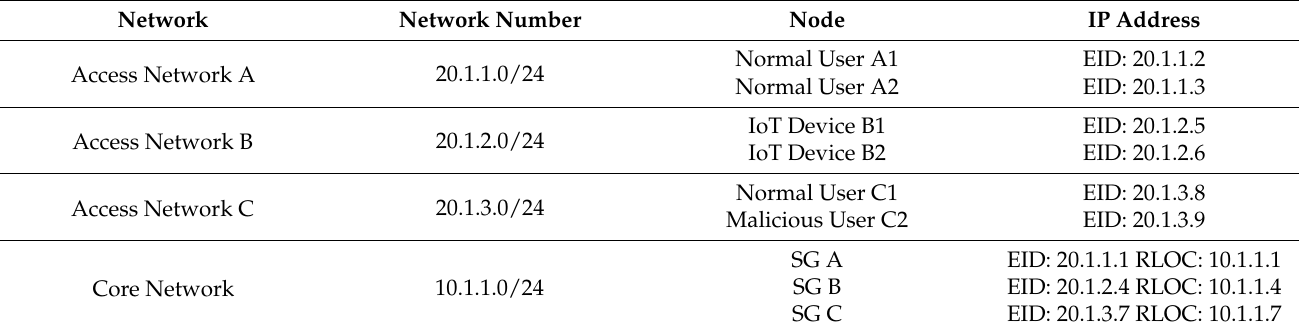
Figure 6. Experimental network topology. Table 2. Network configuration information.